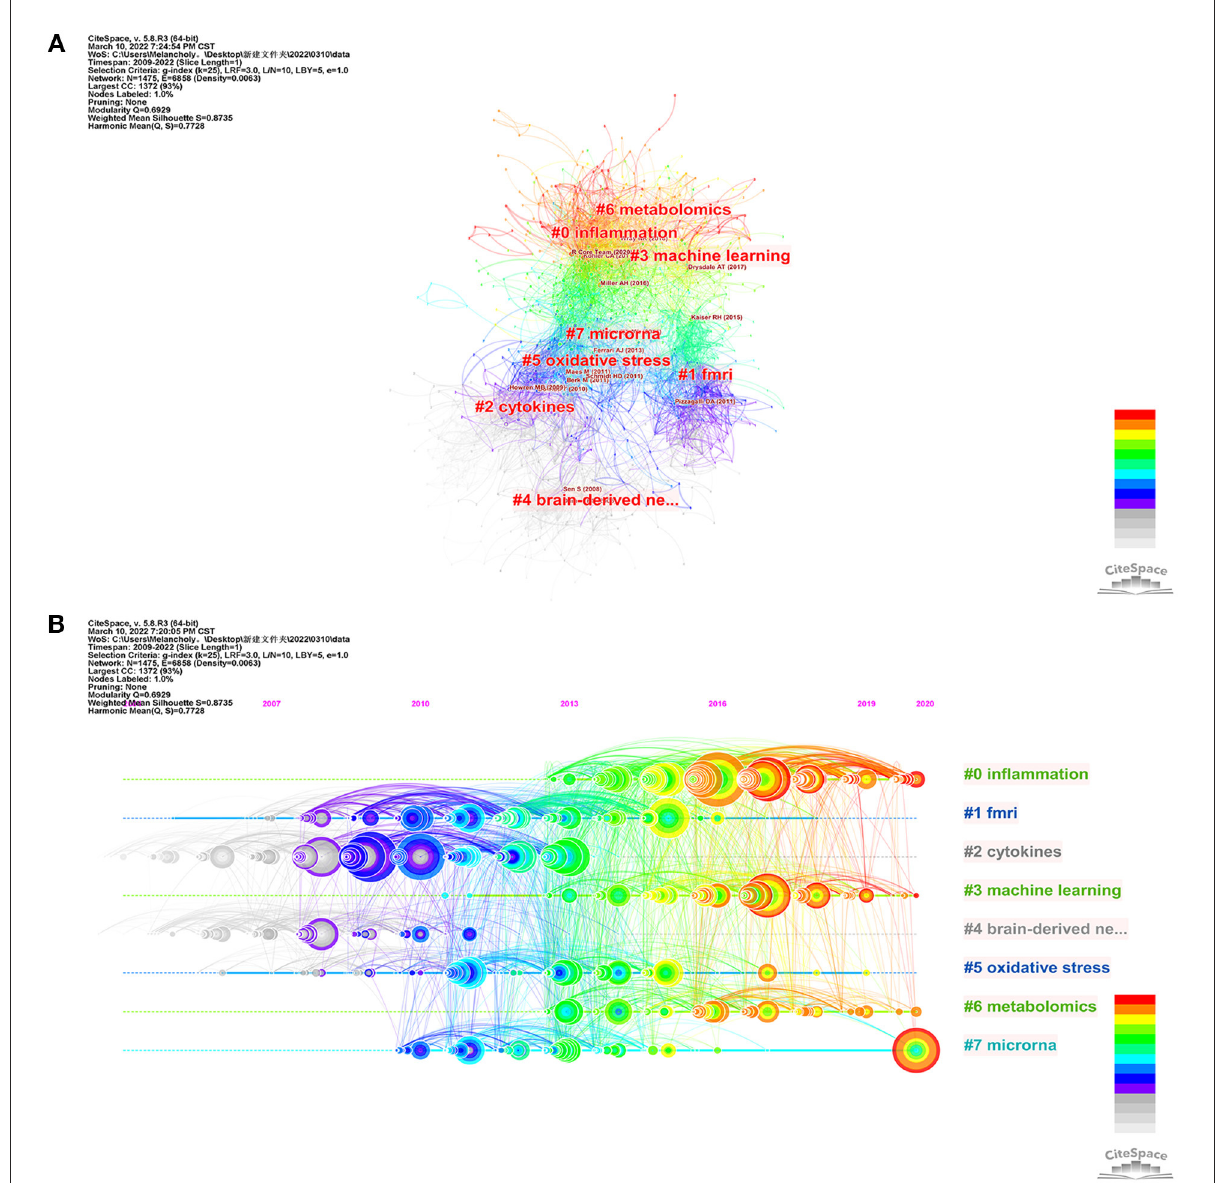
FIGURE6 The visualization of reference co-citation analysis of depression biomarker research. (A) Co-citation network mapping of literature related to depression biomarker research. (B) Timeline related to depression biomarker studies. The nodes in the map denote co-cited references, and links between nodes denote co-citation relationships. The citation rings denote the citation history of a reference. Large nodes or nodes with red tree-rings are either highly cited or have citation bursts in a given time